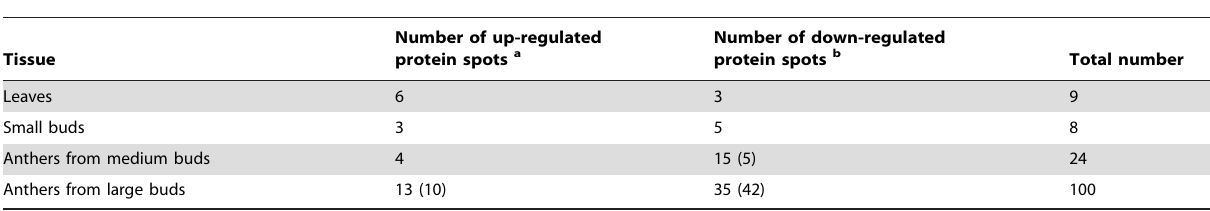
Table 1. Number of differentially expressed protein spots in various tissues between control and MES-treated plants.